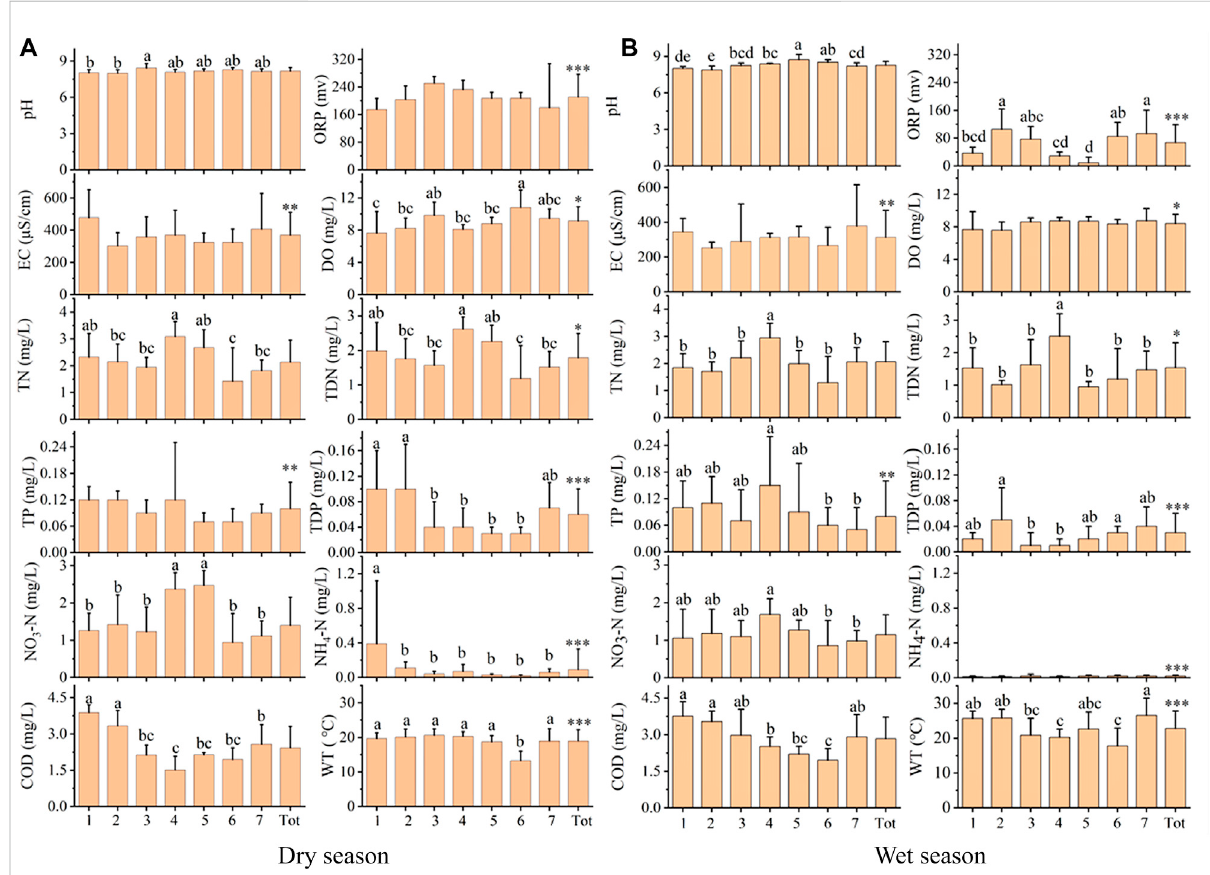
FIGURE 1 Spatial and temporal changes in water quality variables (different letters indicate signi fi cant differences among sub-catchments; asterisks indicate signi fi cant differences betweendry and wet seasons with * at p < 0.05 level, ** at p < 0.01 level, and *** at p < 0.001 level). (A) Dry season